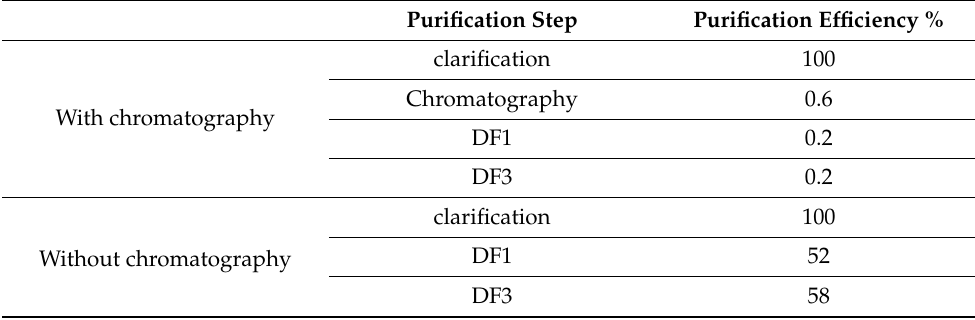
Table 1. HCP purification efficiencies in the DSP with and without